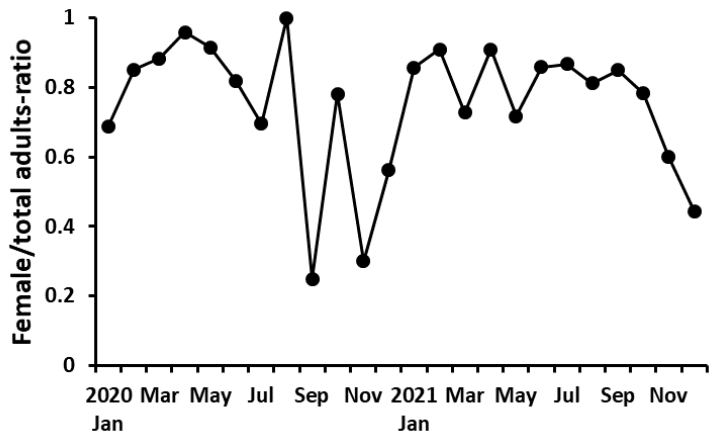
Figure 4. Variation of the proportion of females of P. parvus.